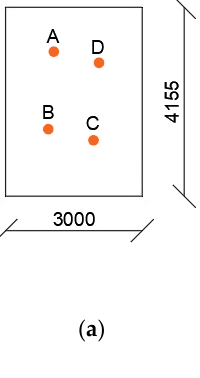
Figure 4. CLT floor and sources positions ( a ); microphone positions in the transmitting room ( b ) and in the receiving room ( c ).